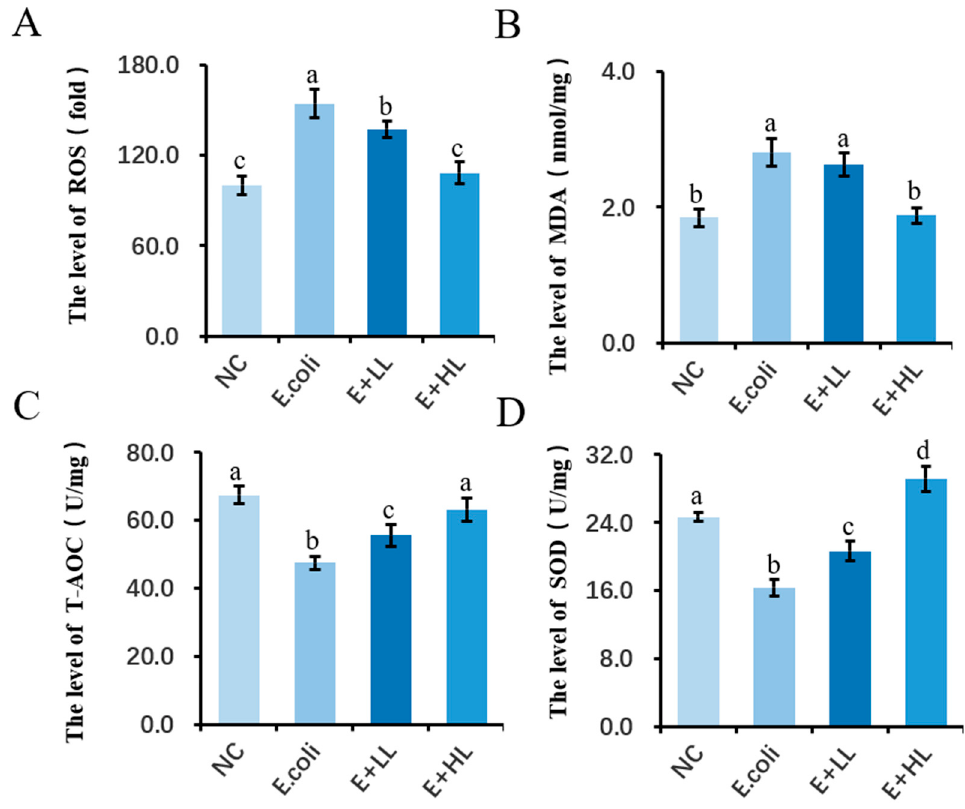
Figure 2. The effect of LBP on the antioxidant capacity of pbMEC. Different concentrations of LBP at 100 μ g/mL or 300 μ g/mL were added to pbMEC, followed by a challenge with 1 × 10 7 /mL E. coli for an additional 6 h. ( A ) Determination of ROS content in pbMEC. ( B ) Detection of MDA content in pbMEC. ( C ) Detection of T-AOC content in pbMEC. ( D ) Detection of SOD content in pbMEC. Results are presented as means ± SEM. Letters in superscripts represent that the difference between groups was significant according to statistical analysis ( p <